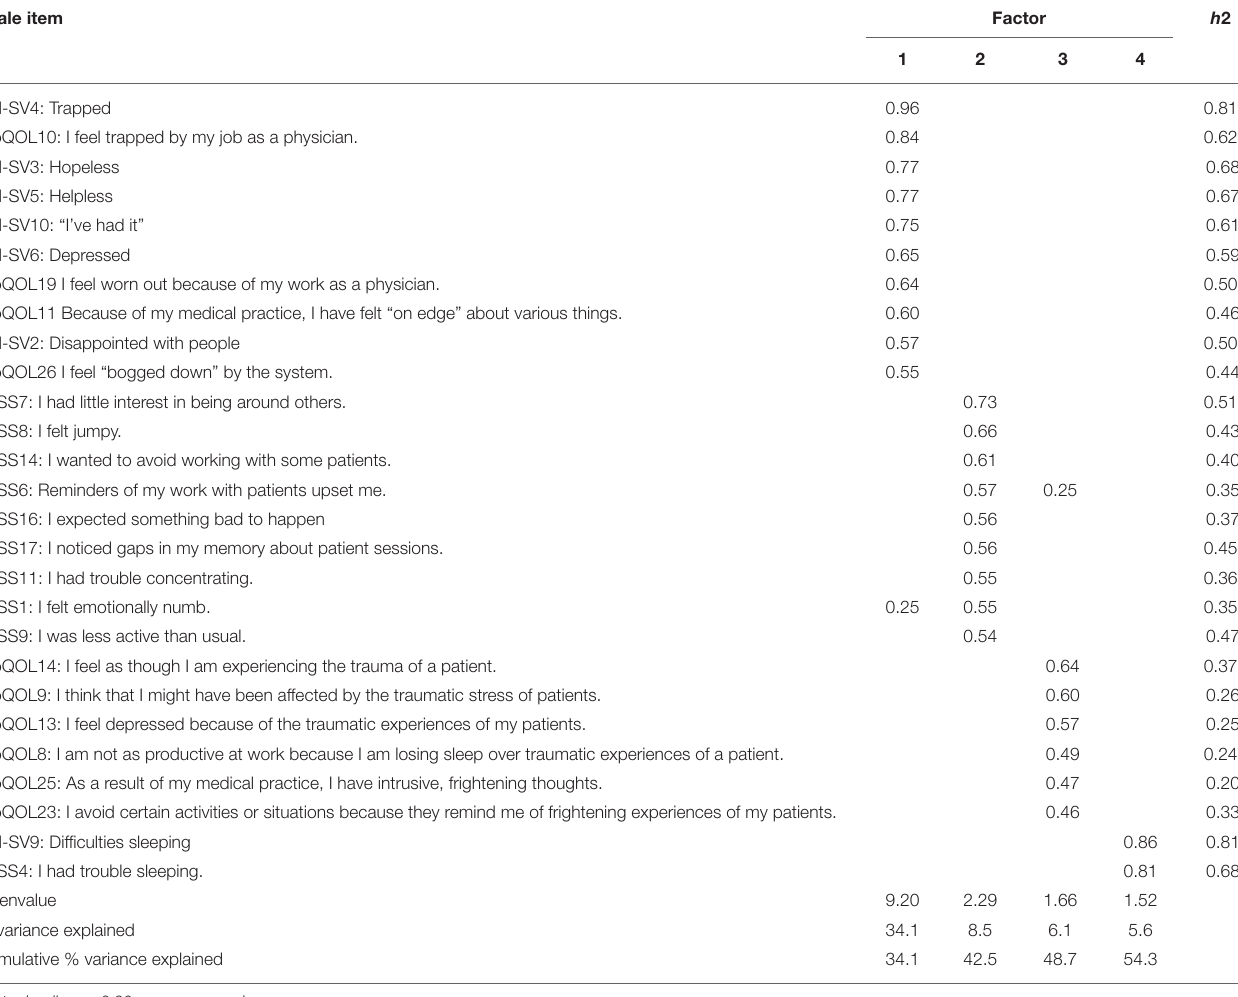
TABLE 3 | Exploratory factor analysis of the BM-SV, ProQOL-21, and STSS: factor loadings from the pattern matrix of the final four-factor principal axis factoring promax-rotated solution. Scale item